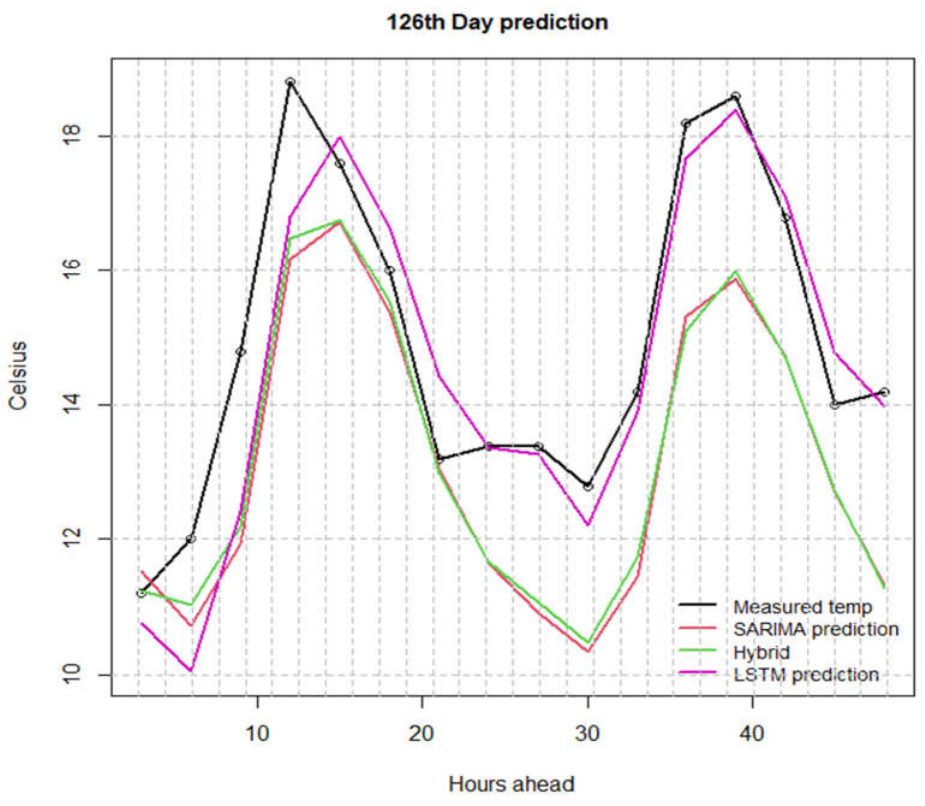
Figure 5. Comparison of SARIMA, LSTM and hybrid with real data on temperature example for 2-day prediction horizon during March; stable parabolic temperature profile.